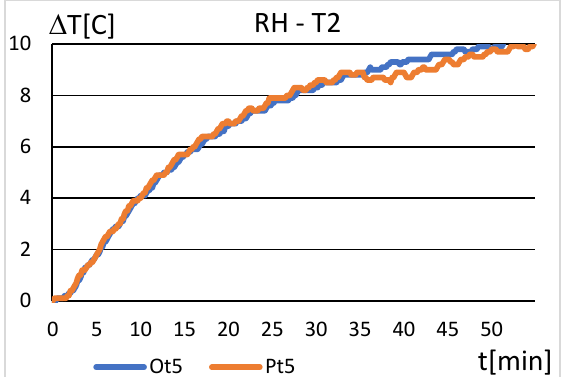
Figure 21. Increment temperature of the stock-rail web (T2) in resistance heating RH for: Ot5 — the switch-rail moved away from the stock- rail and the ambient temperature −5 ° C; Pt5 — switch-rail in contact with the stock- rail and the ambient temperature −5 ° C.